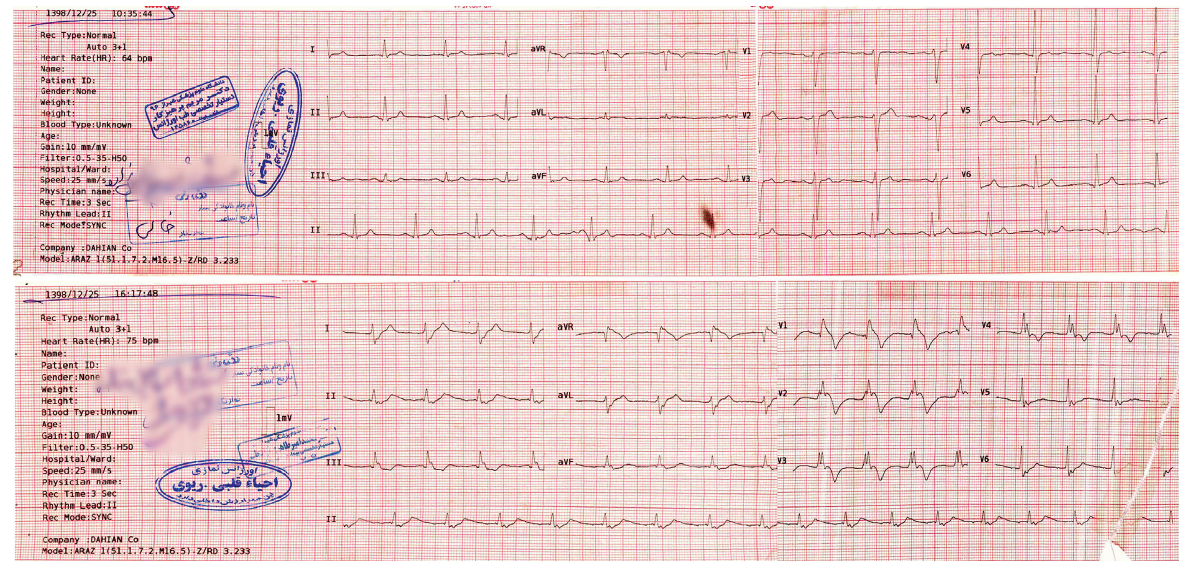
Figure 1: Patient with type 1 Brugada pattern, before and after presentation. Table 1: Association between Brugada phenocopies and demographic variables, past medical history, mortality, complication in hospital, and laboratory